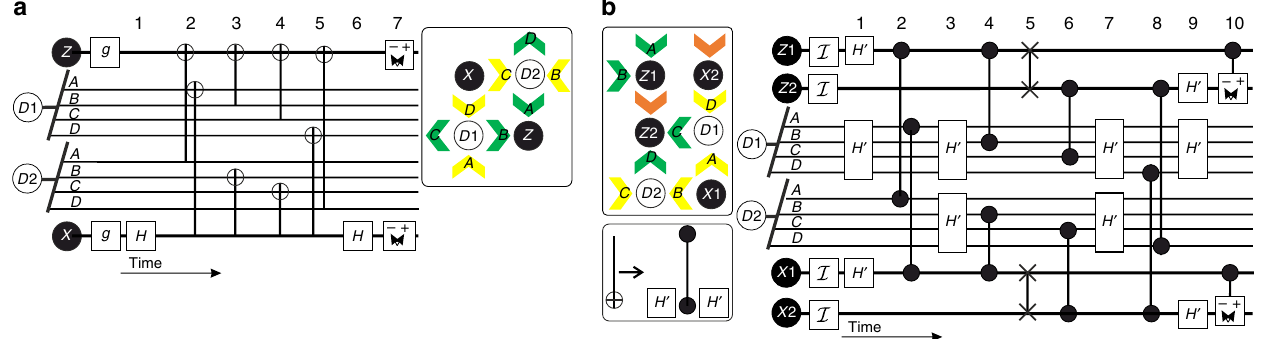
Fig. 4 Surface code operation. a General surface code operation 3 and b surface code operation for spin qubits. To match this error correction scheme with a spin qubit system, the CNOT gate is decomposed into CPHASE and Hadamard operations, which are elementary operations for quantum dot qubits. CPHASE operations with quantum dot qubits usually result in additional ^ z rotations, which can be corrected using single qubit gates. Here this is included in the Hadamard, resulting in a Hadamard-like operation. Read out is via a parity measurement requiring two quantum dots, such that a unit cell consists of six (schematic in b ) instead of the usual four (schematic in a 3 ) qubits. A single unit cell contains now two data qubits, D 1 and D 2 , and four measurement qubits, Z 1 , Z 2 , X 1 , and X 2 . Each of these qubit classes has a well-de fi ned independent qubit resonance frequency. To enable all nearest neighbor operations, an additional SWAP operation is included, resulting in protocol b . A single cycle of initialization, control, and readout corresponds to 10 steps. Note that the labels A,B,C , and D refer to the data qubits associated with the respective measurement